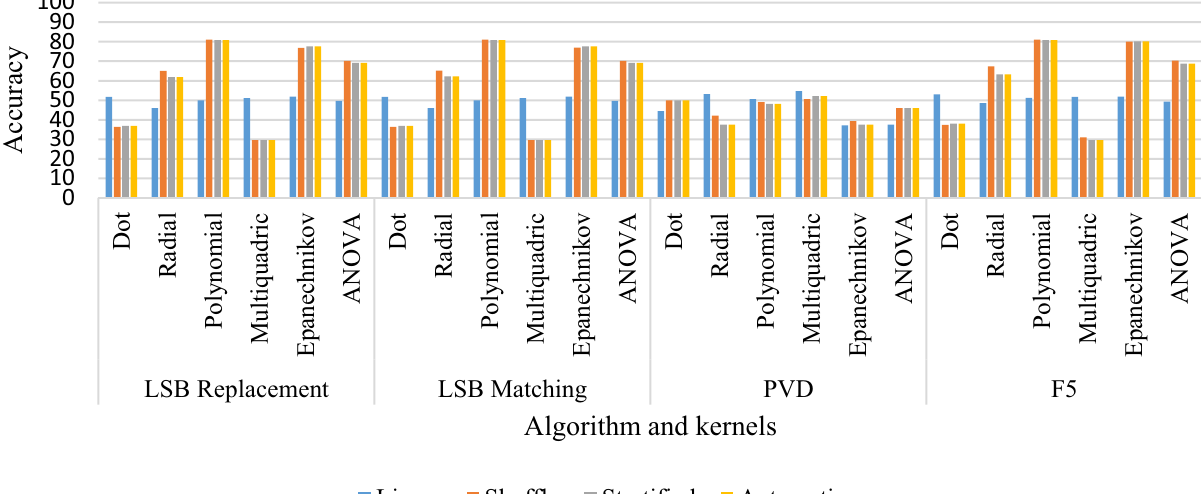
Graph 4. Result of classification of calibrated images using SVM-PSO for